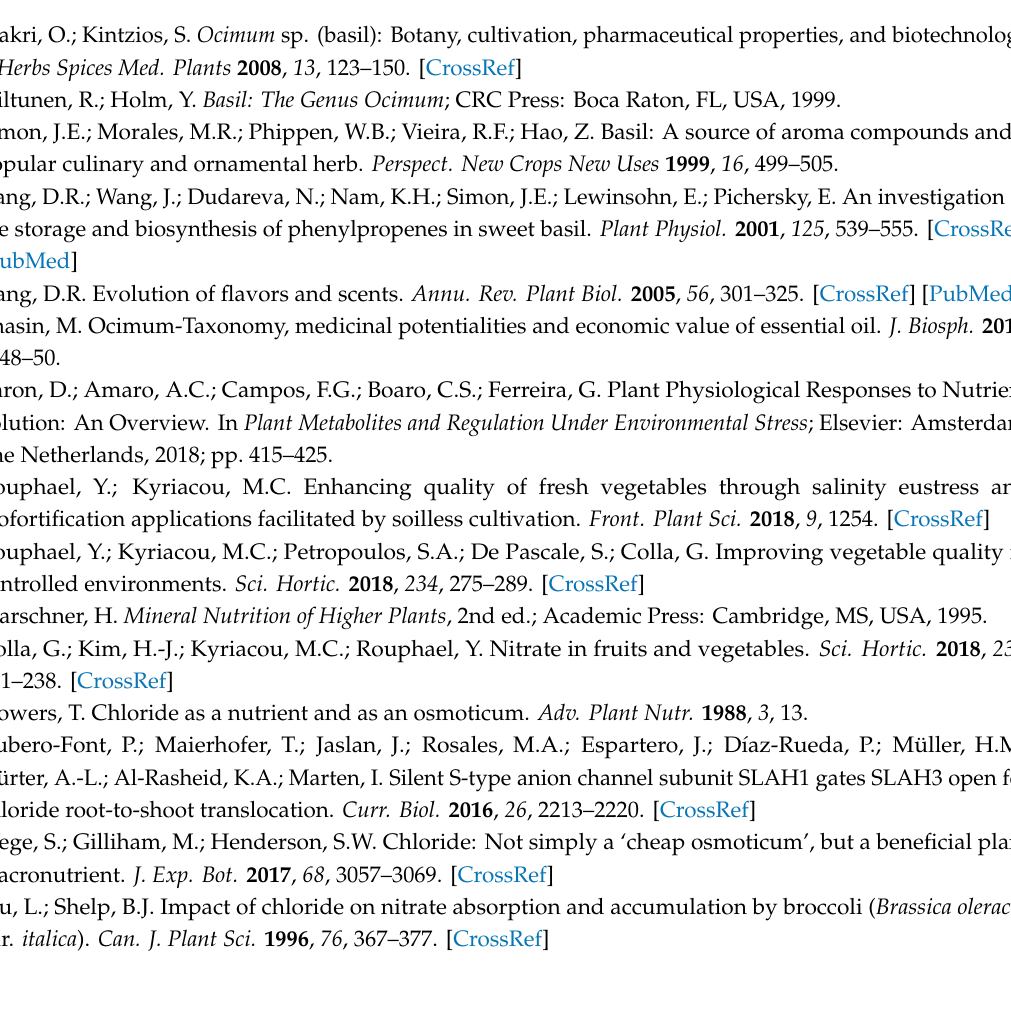
Figure S1. Scree plot of the eigenvalues of the principal components; Figure S2. Correlogram (Pearson) of the quantitative variables measured in the two successive harvests, CT1 and CT2. Pairwise correlations are color-mapped according to the color scale of the bar on the right-hand side. Asterisks indicate statistically significant correlations (*: p < 0.05; **: p <